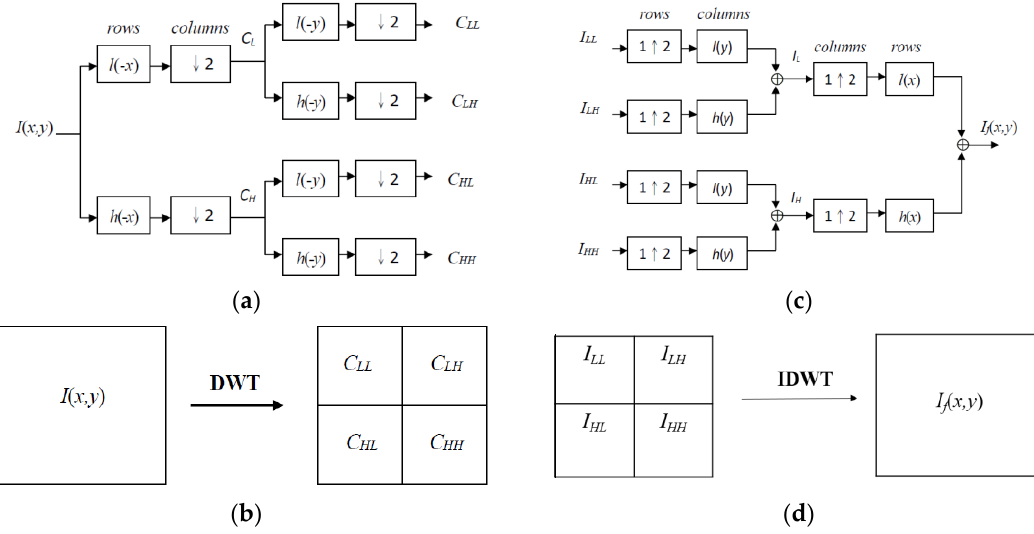
Figure 7. ( a ) One-stage structure of the two-dimensional DWT; ( b ) Relative locations of decomposition coefficient matrices in the two-dimensional DWT; ( c ) One-stage structure of the two-dimensional IDWT; ( d ) Relative locations of fusing coefficient matrices in the two-dimensional IDWT.